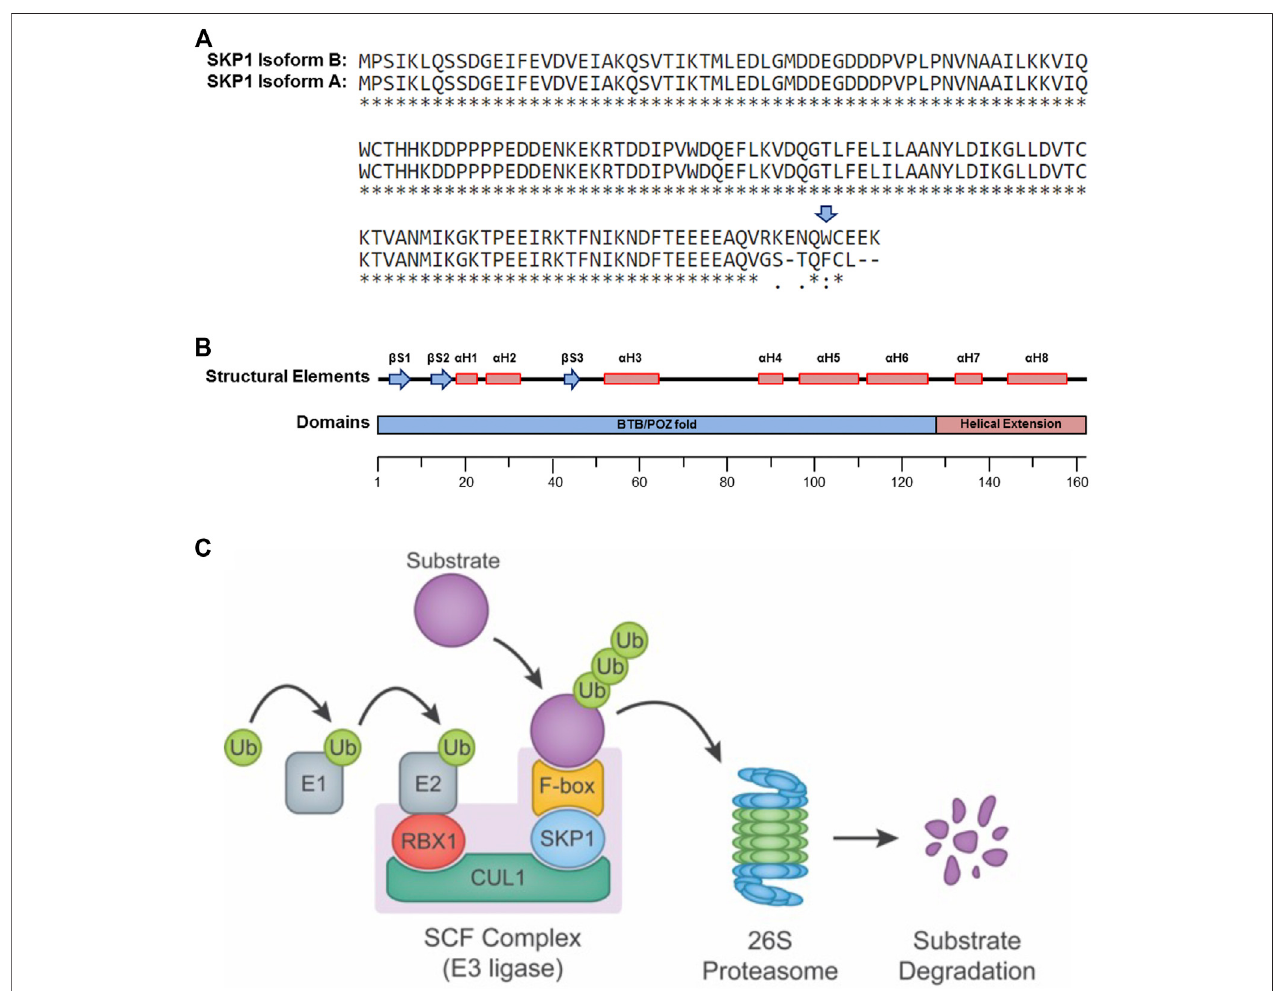
FIGURE 1 | SKP1 Structure and Function. (A) Single amino acid sequence alignment of the two SKP1 (isoform A and isoform B) reveals sequence divergence within their carboxy-terminal tails. Sequence alignments performed using UniProt (Universal Protein Resource) (Altschul et al., 1990). Tryptophan 159 (W159), present only within Isoform B is highlighted by a blue arrow. A “ * ” identi fi es conserved amino acid positions, while “ : ” and “ . ” identify amino acid positions with similar or weakly similar properties, respectively. (B) Schematic depiction for the secondary structural elements (top) and protein domains (bottom) of SKP1 isoform B ( β S, beta- sheet; α H, alpha-helix; BTB/POZ, broad complex, tramtrack and bric-à-brac(BTB)/poxviruses and zinc fi nger (POZ)). (C) Diagram depicting the SCF complex and its function in targeting protein substrates for poly-ubiquitination and proteolytic degradation by the 26S proteasome. The SCF complex consists of three invariable components (RBX1, CUL1, and SKP1) and one of 69 variable F-box proteins that confers substrate speci fi city. In general, ubiquitin (Ub) moieties are transferred to a protein substrate through the sequential actions of an E1 (activating) and an E2 (conjugating) enzymes in conjunction with an E3 (ligase) enzyme (e.g., SCF complex).